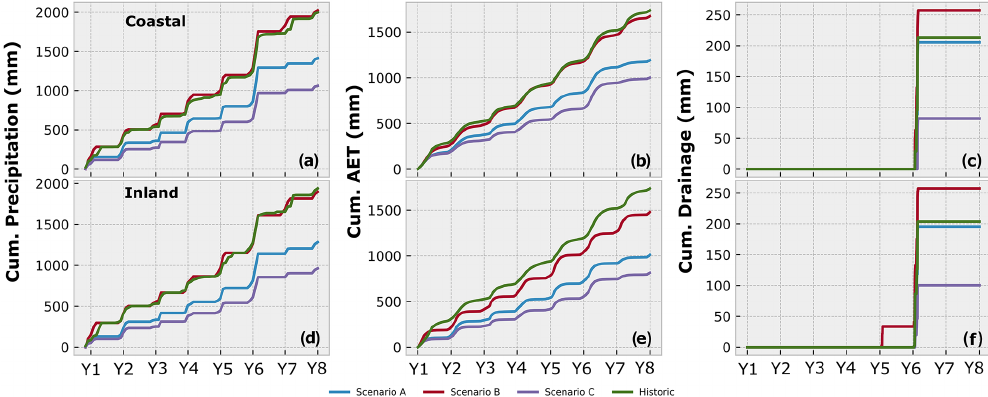
Figure 9. Cumulative water balance results for the coastal (a–c) and inland (d–f) sites. (a, d) Cumulative precipitation shows the changes in available water between different scenarios. (a, d) The proportion of available water used as AET varies among scenarios and shows a tight coupling of AET and P at the coastal site. (c, f) Drainage only occurs after reaching certain thresholds of monthly precipitation with the inland site benefitting from the added intensity in scenario B, which resulted in extra drainage in